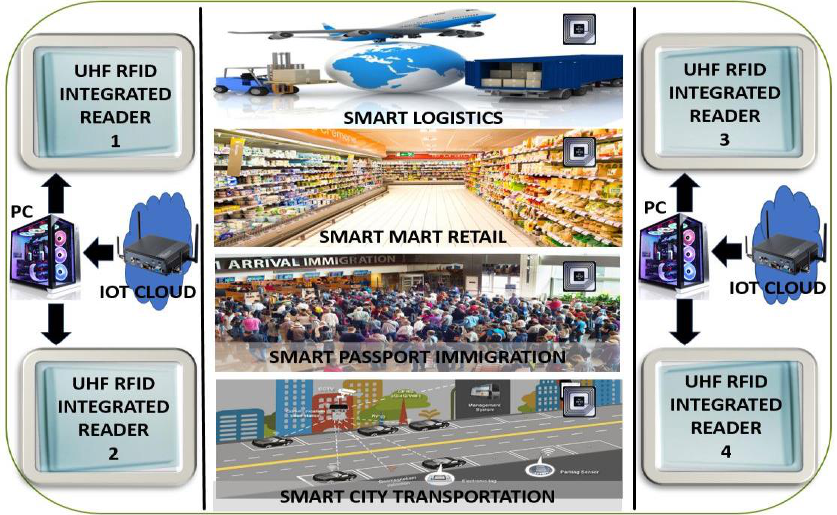
Figure 13. I-RFID indoor and outdoor work mechanism for IoT in smart X environments (e.g., smart logistics, smart market retail, smart passport immigration clearance, and smart city transportation).